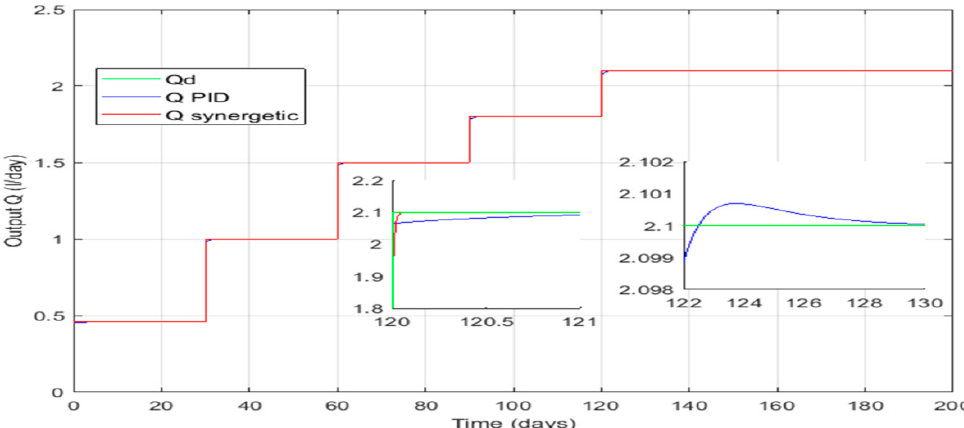
Energies 2018 , 11 , x FOR PEER REVIEW transitions. Overall synergetic performance, such as response time and steady-state error are improved compared to PID. Figure 2. Time evolution of biogas flow rate under PID control and synergetic control for T = 0.01.